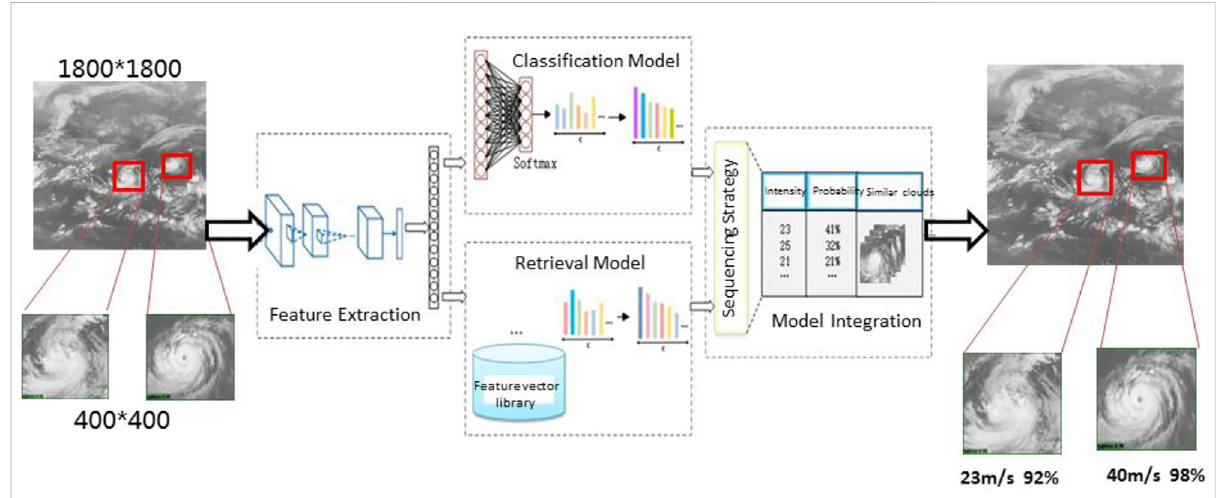
FIGURE 3 Flowchart of the intelligent intensity determination model of typhoon based on image classi fi cation and